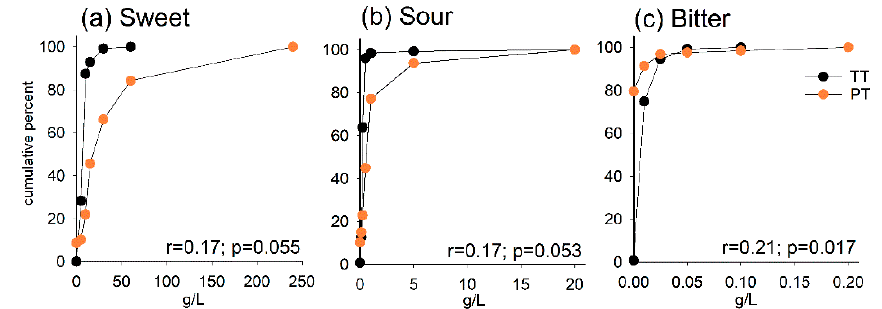
Figure 1. Cumulative percentage curves for taste threshold (TT, black) and preferred taste (PT, orange) by increasing test solution concentrations for ( a ) sweet, ( b ) sour and ( c ) bitter. Spearman correlation coefficients (r) are shown at the bottom of each plot.